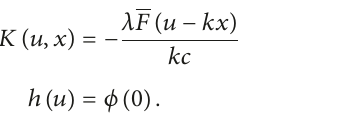
which is a linear VIE of the second kind with 𝐾(𝑢, 𝑥) and ℎ(𝑢) as given in